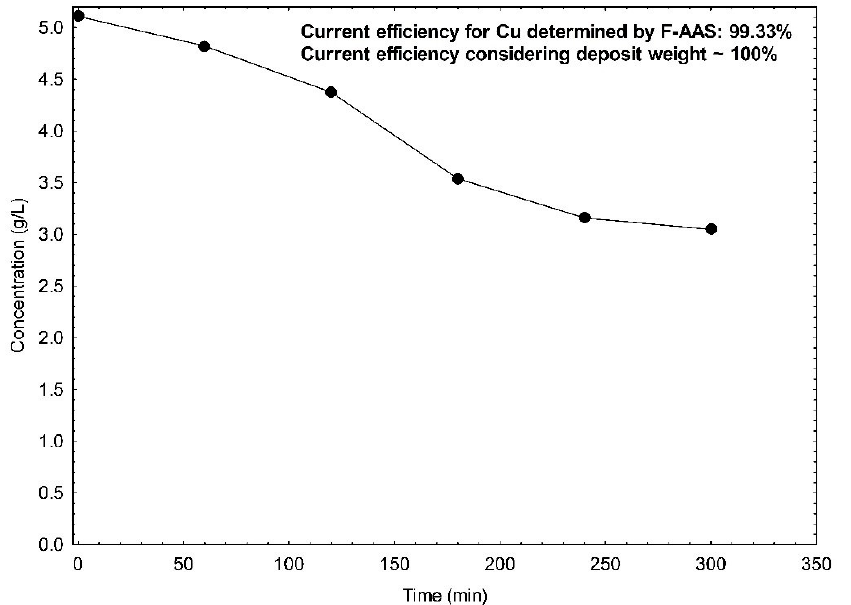
Figure 11. Variation of copper in the supercritical leachate with electrowinning time. Conditions: 250 A/m2; pH = 4; room temperature (25 °C).